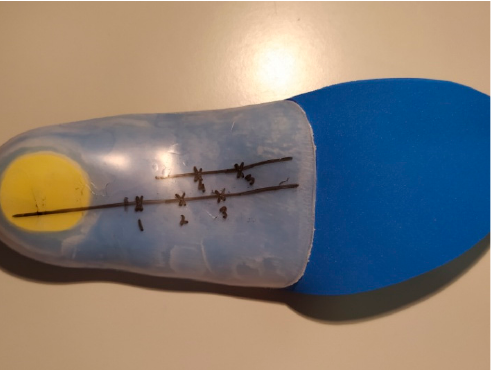
Figure 3. Orthopedic insoles manufactured for this study (crosses marked in black show the five Shore hardness measurement